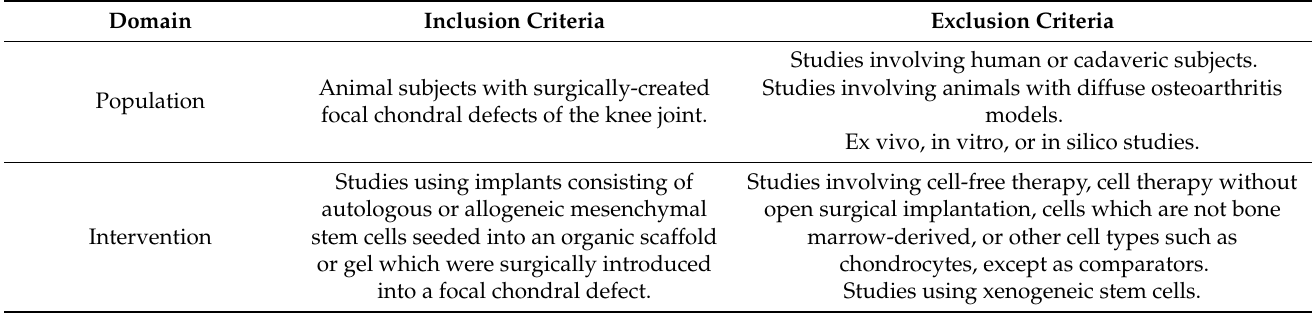
Table 3. PICOS inclusion and exclusion criteria for study